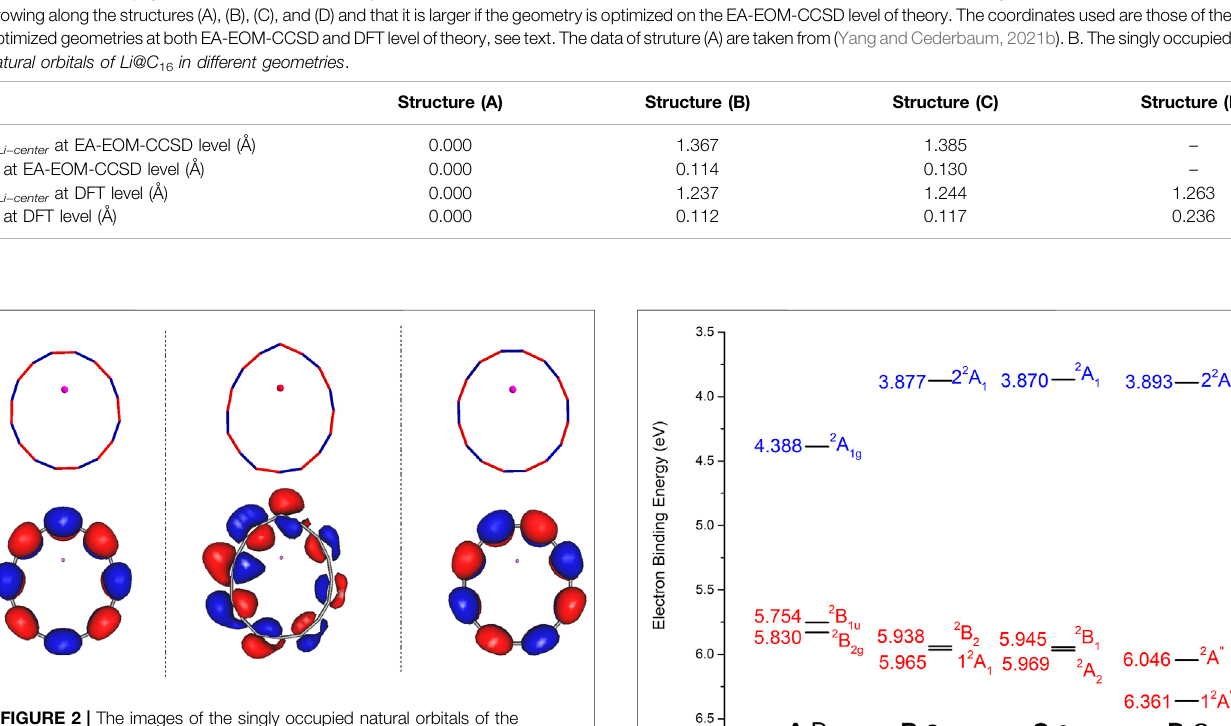
TABLE 1 | The distance R Li − center between the Li + cation and the center of the carbon ring, and the standard deviation σ r of the distances of the carbon atoms and the ring center of the Li@C